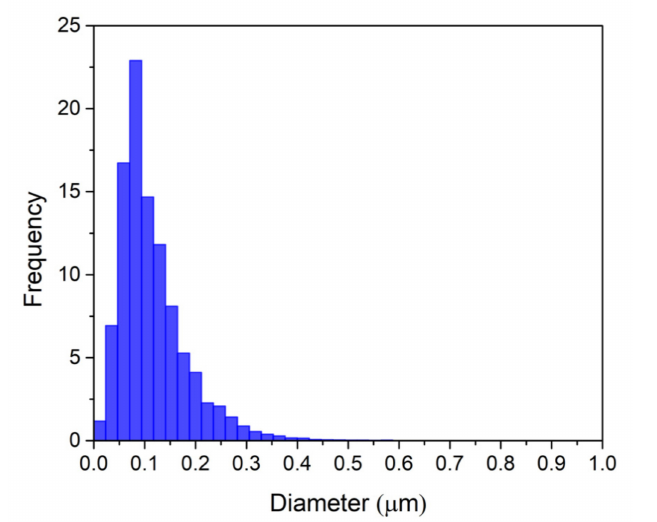
Figure 2. DiameterJ analysis of SEM images of LSM nanofibers after thermal treatment (Figure 1c,d). XRD measurement was carried out on the heat-treated LSM nanofibers and citrate route powders to verify the achievement of the desired crystal phase. In Figure 3, the experimental patterns were reported together with the reference pattern. The experimental patterns contained all the peaks related to the reference, without any additional peaks. It confirmed that the thermal treatment permitted us to achieve crystallinity.